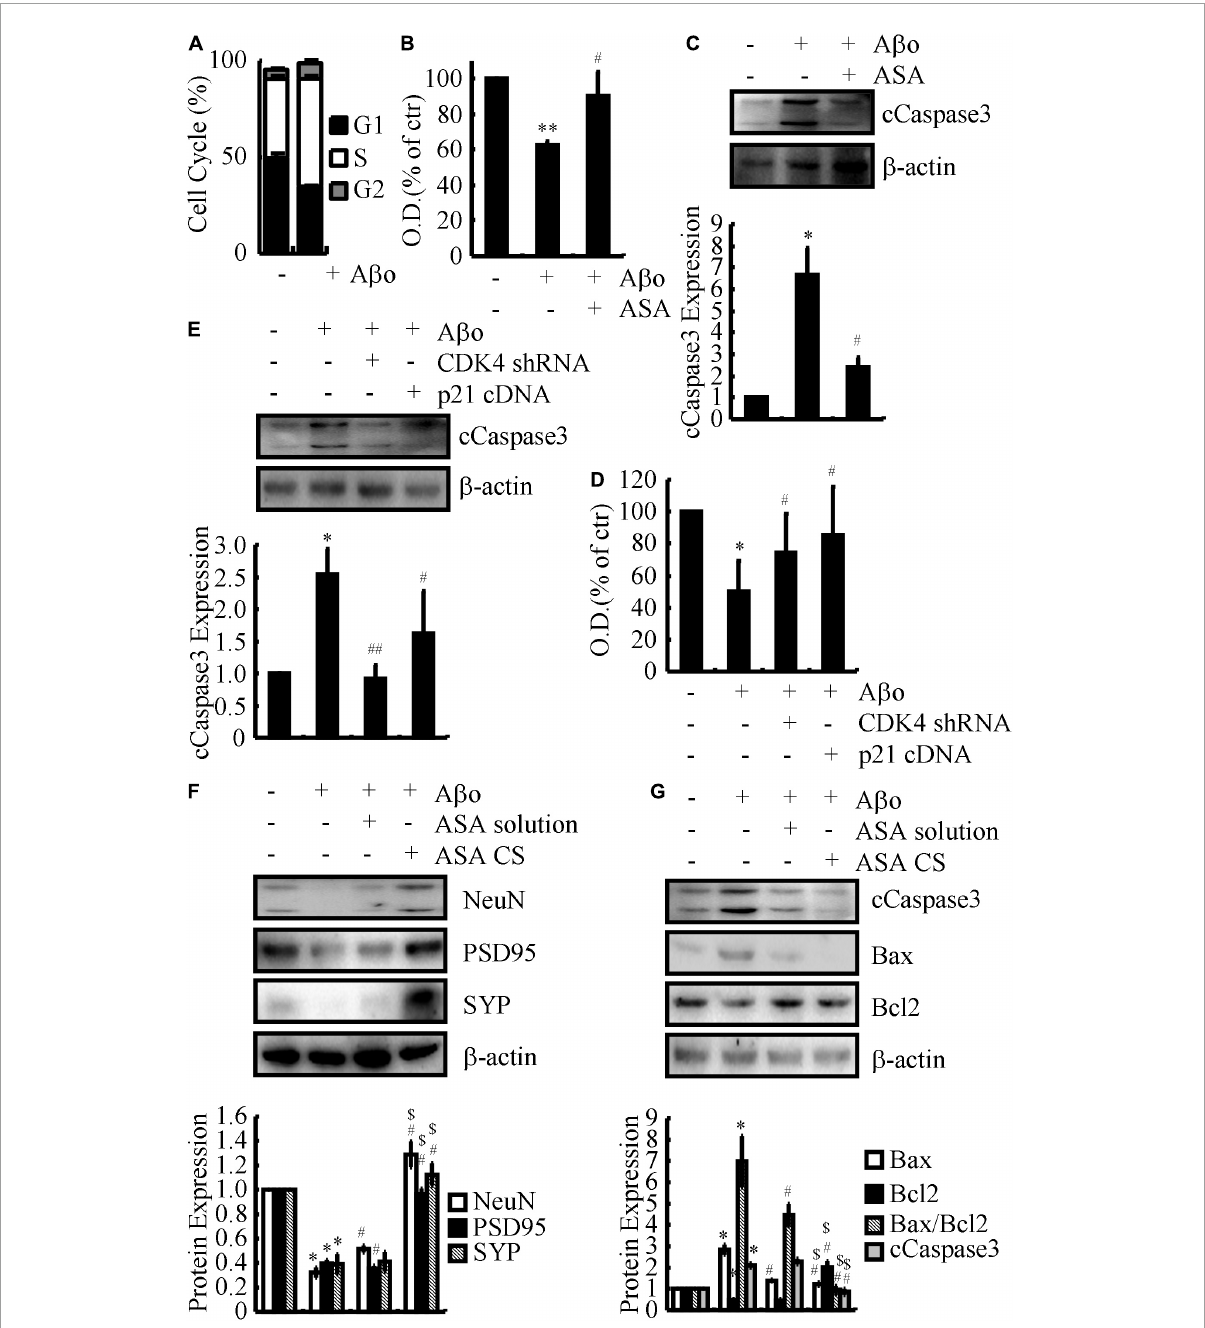
FIGURE4 CDK4 and p21 mediate the effects of ASA on protecting neurons from cell cycle re-entry, leading to inhibit the apoptosis of neurons. (A–C) N2a cells were treated with A β o (20 nM) in the absence or presence of ASA (10 µ M). (D,E) N2a cells were treated with A β o (20 nM) in the absence or presence of transfecting CDK4 shRNA or p21 cDNA. (F,G) C57BL/6 mice were injected (i.c.v.) with A β o (2 ng/5 µ l) in the absence or presence of intranasally administrating ASA solution or ASA CS. (A) The cell cycle was determined by flow cytometry. (B–D) The survival rate of N2a cells were determined by MTT assay. (C,E–G) The production of caspase 3 and the protein expression of NeuN, PSD95, SYP, Bax, and Bcl2 were determined by western blots. β -actin served as an internal control. The optical density of the bands was analyzed using ImageJ software. Data are presented as the means ± S.E. of independent experiments, ∗ p < 0.05; ∗∗ p < 0.01 compared to vehicle-treated controls, # p < 0.05; ## p < 0.01 compared to A β o-treated alone, $ p < 0.05 compared to ASA solution-treated